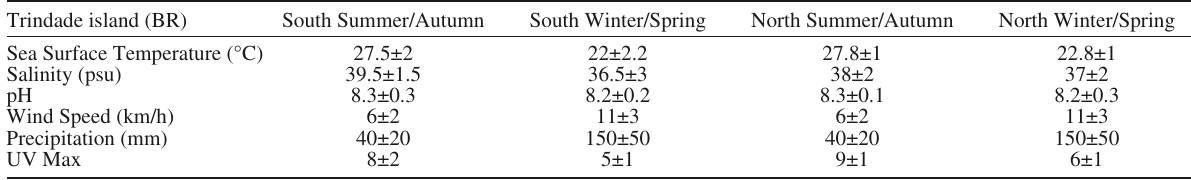
Table 2. – Abiotic data ( mean±SD ) monitored in situ from Trindade Island (Southern Brazil, South-Western Atlantic), during the summer and winter cruises in 2014 and 2015, comparing the south and north faces. Trindade island